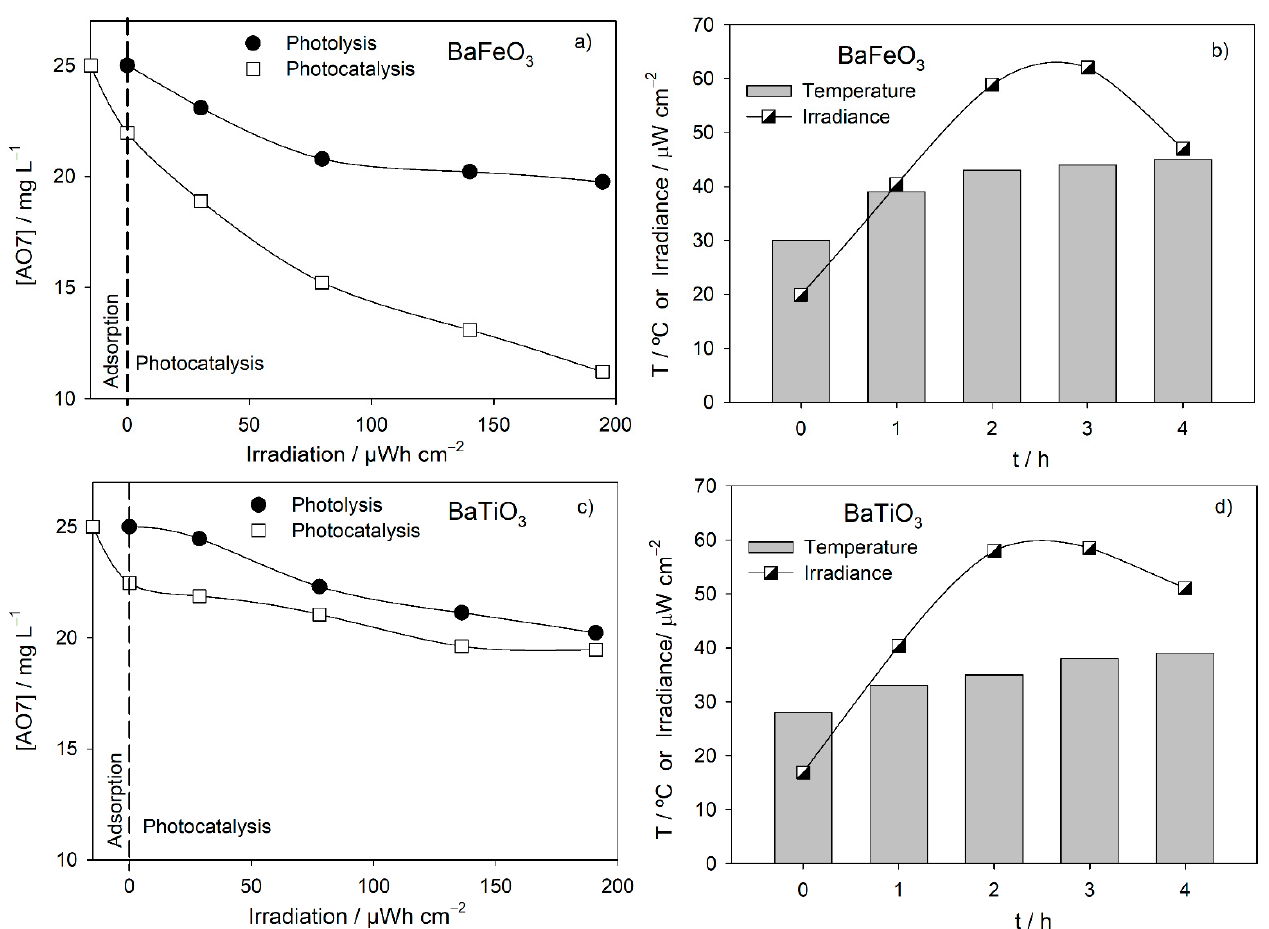
Figure 2. Decay in time of the AO7 concentration, measured as absorbance at 484 nm, for the assays with sunlight using as ( a ) BaFeO 3 and ( c ) BaTiO 3 photocatalyst and respective temperature and sunlight irradiance variations ( b , d ).